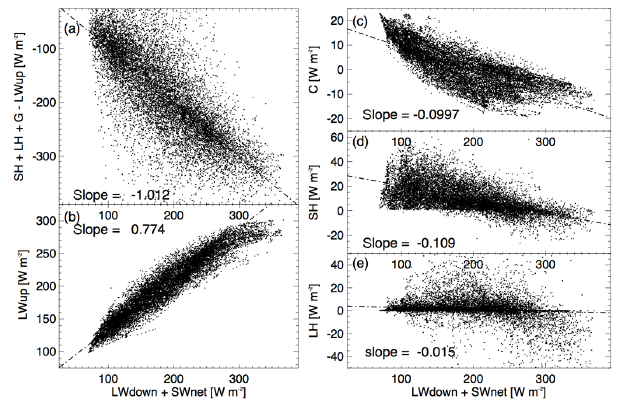
Figure 7. Statistics of (a) LW ↓ + net SW, (b) surface tempera- ture, and (c) LW ↑ for the period spanning January 2011–June 2014. (d) Statistics of the bulk Richardson number for the period span- ning March 2012–June 2014. The black distribution represents all quality-controlled cases. The red (blue) distributions represent pe- riods when the wind speed < 8ms − 1 and the solar zenith angle is < 70 ◦ ( > 90 ◦ ). Distributions are represented by box-and-whisker plots (the box indicates the 25th and 75th percentiles, the whiskers indicate 5th and 95th percentiles, the middle line is the median, and the ∗ is the mean).